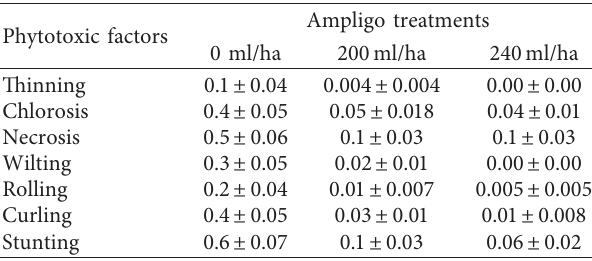
Table 5: The effect of Ampligo treatments on the phytotoxic factors considered during sampling for FAW maize leaf and